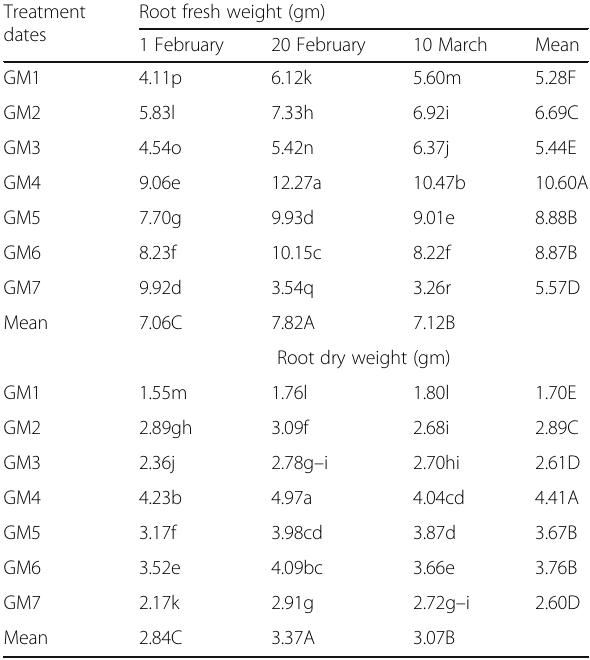
Table 8 Effect of planting dates and different growing media and the interactions between them on root fresh and dry weight of pistachio seedlings Treatment